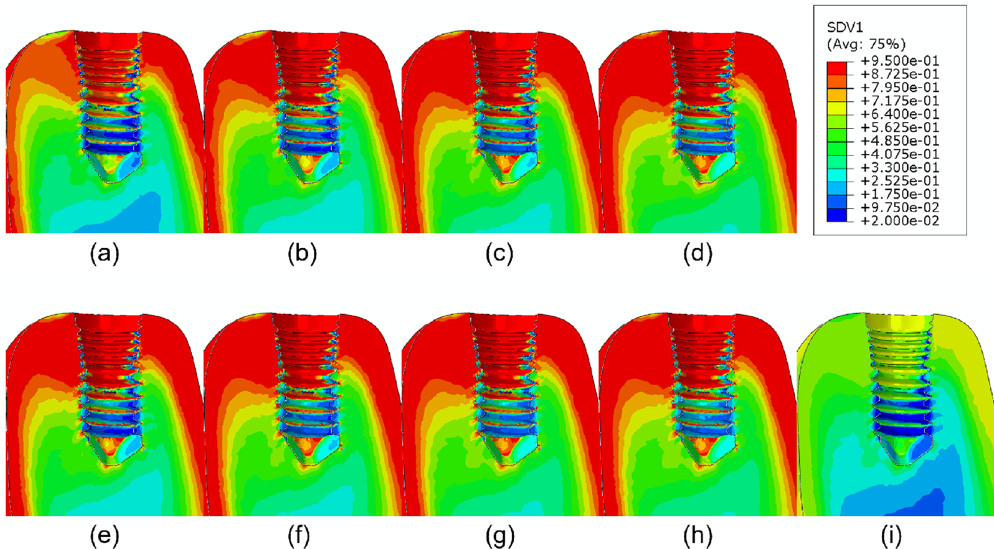
Figure 7. Bone volume fraction distribution after 540 days of simulation for different doses of ( a ) 0.1, ( b ) 0.3, ( c ) 1.0, ( d ) 3.0 mg/kg of denosumab and doses of ( e ) 0.25, ( f ) 0.5, ( g ) 1.0, ( h ) 2.0 mg of bisphosphonates and ( i ) control implant.